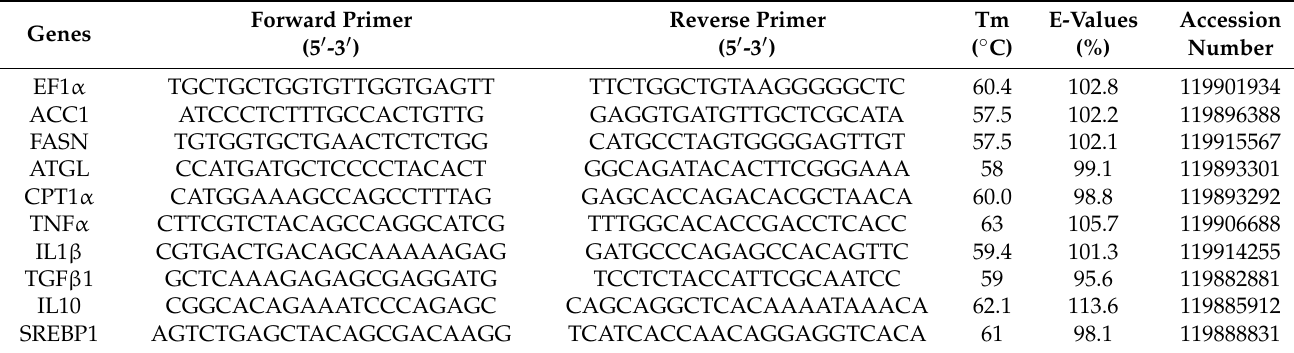
Table 2. Primer sequences for